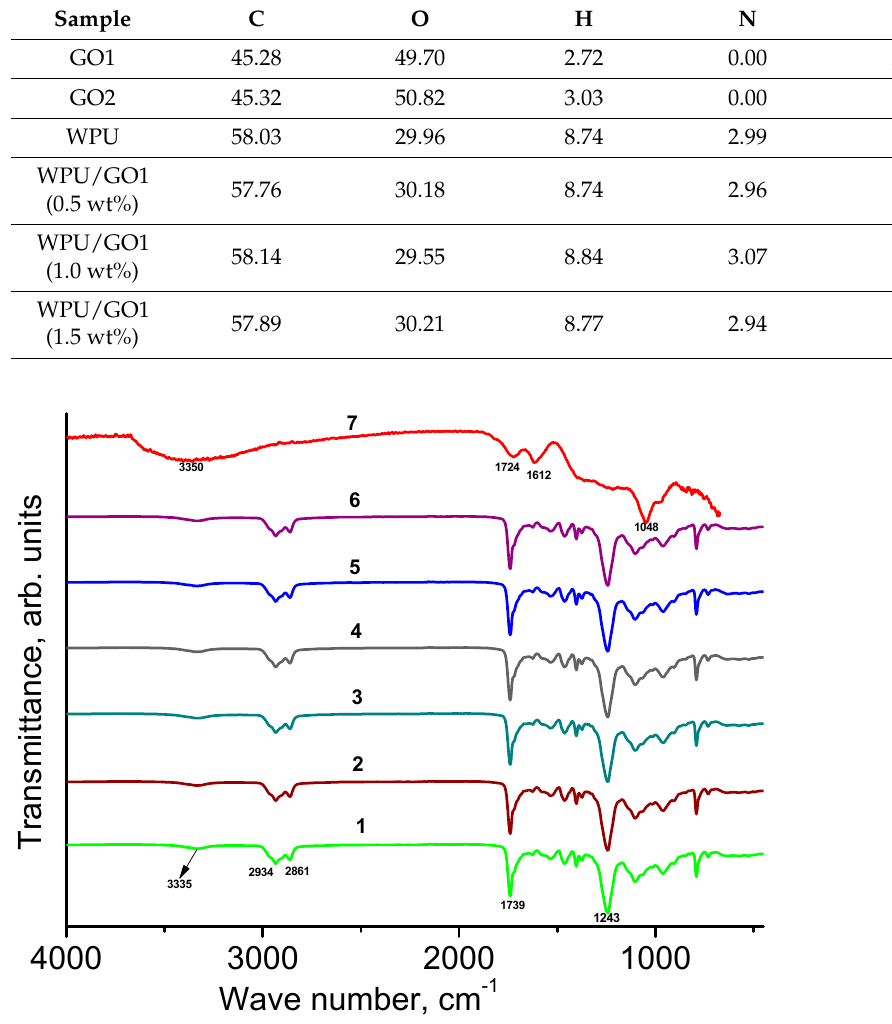
Figure 2. IR spectra of WPU film ( 1 ), WPU/GO1 composites with GO1 content of 0.1 ( 2 ), 0.5 ( 3 ), 1.0 ( 4 ), 1.5 ( 5 ), and 2.0 ( 6 ) wt%, and GO1 powder ( 7 ). The absorption band in the spectrum of WPU film at ~3335 cm –1 is due to stretching vibrations of N − H bonds of the urethane block [22,28,30,39,40]. Bands at 2934 cm − 1 and 2861 cm − 1 correspond to stretching vibrations of C − H bonds. Vibrations of C=O bonds correspond to the band at 1739 cm − 1 . An assignment of the intense peak at 1243 cm − 1 in the literature is ambiguous. In accordance with [41], we relate this band to ν (C − O) of the urethane group. The absence of an isocyanate band at 2275 cm − 1 indicates that the initial polymer is free of unreacted monomers since − N=C=O groups from MDI were successfully linked to the formation of urethane bonds [42].